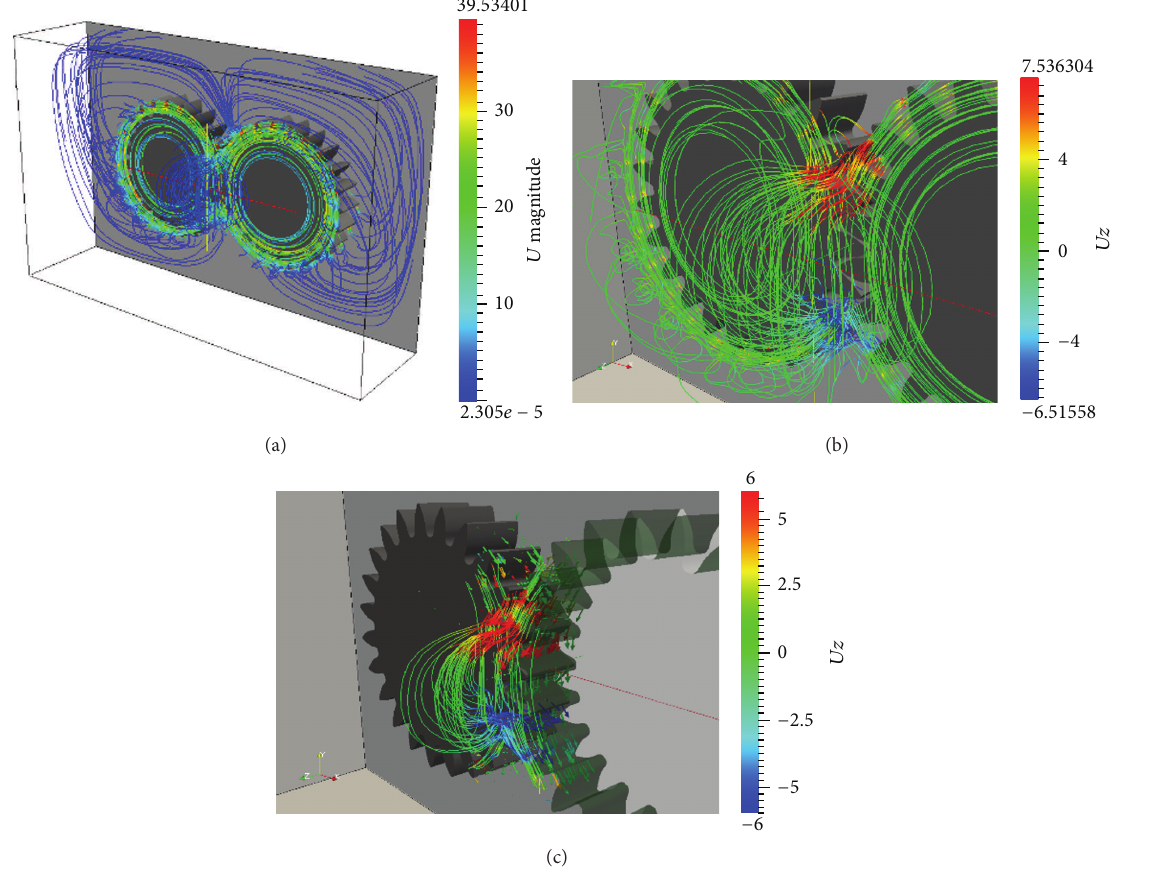
Figure 6: (a) Path-lines ( 𝑈 [m/s]) and (b, c) detail ( 𝑈𝑧 [m/s]).